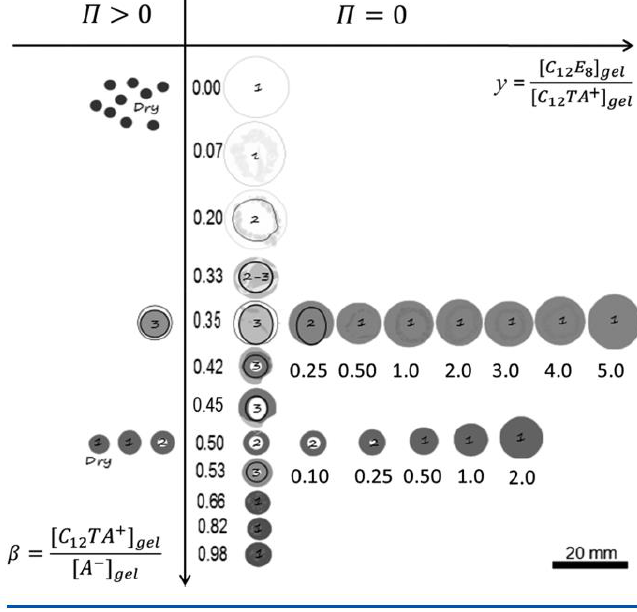
Figure 17. Graphical presentation of the phase behavior of the spherical macrogels investigated by Andersson and Hansson (A&H); see text for details. Figure taken from ref. [22]. Reprinted with permission. Copyright 2017 American Chemical Society.